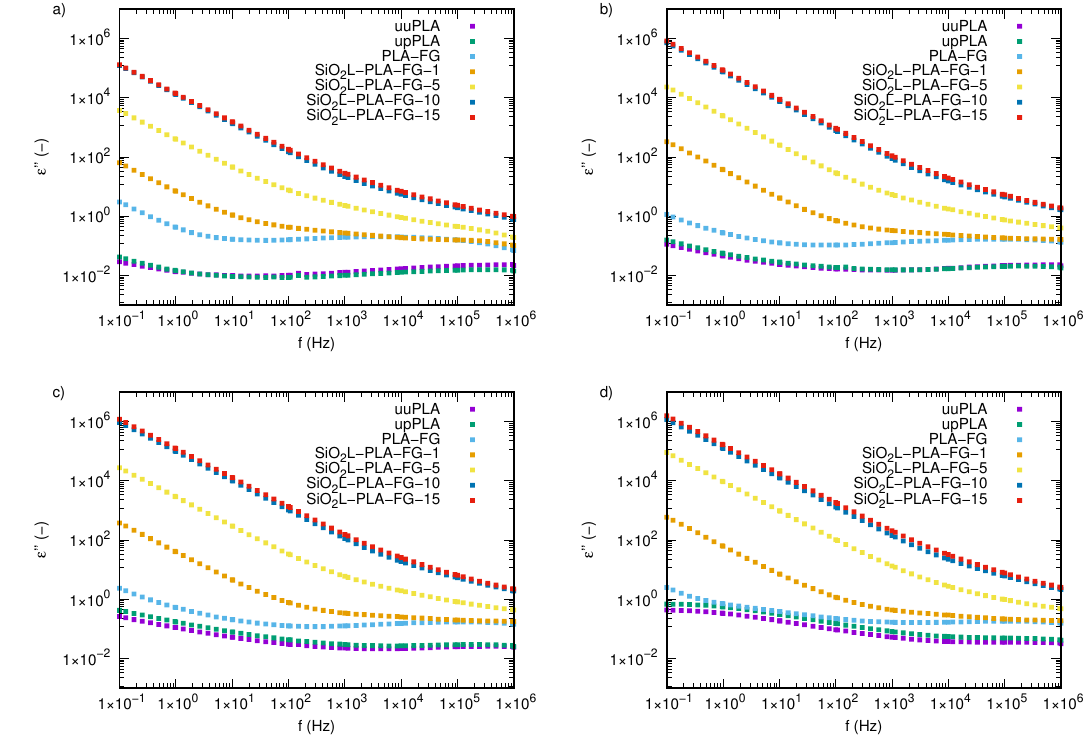
Figure 6. The imaginary part of the complex permittivity of silicon-dioxide–lignin nanocomposites as a function of frequency for ( a ) 293.15 K, ( b ) 323.15 K, ( c ) 328.15 K, and ( d ) 333.15